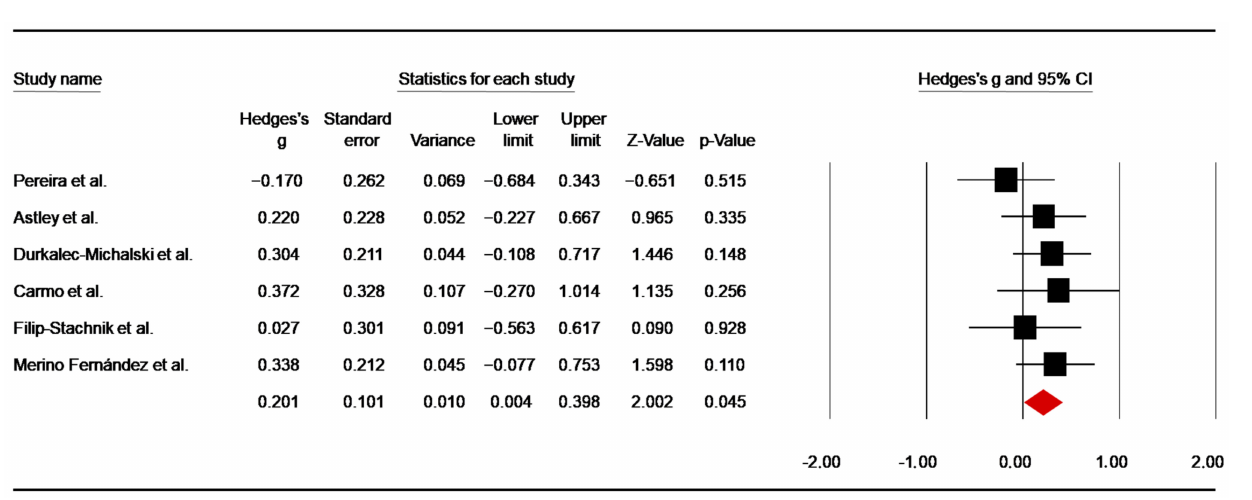
Figure 10. Forest plot of the effect of caffeine intake on HR 1min [45,47,50,51,55,57].